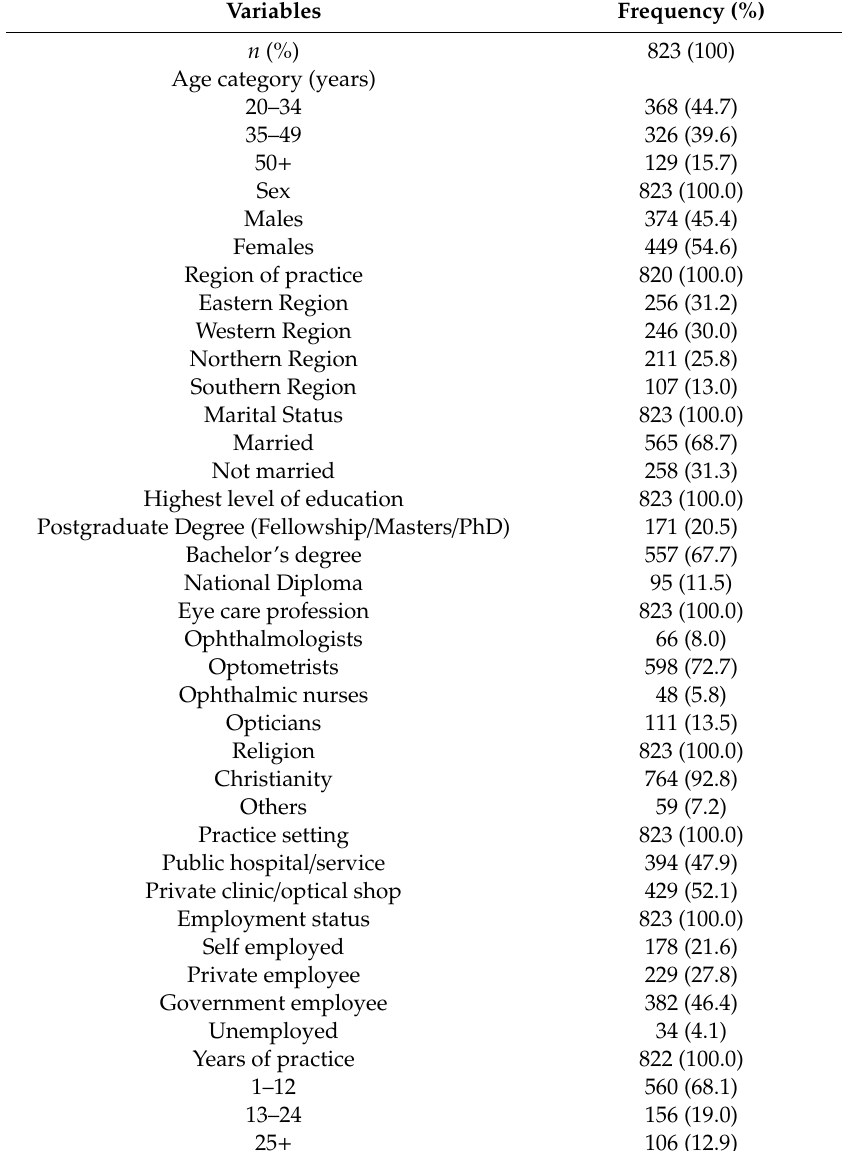
Table 2. Demographic profile of